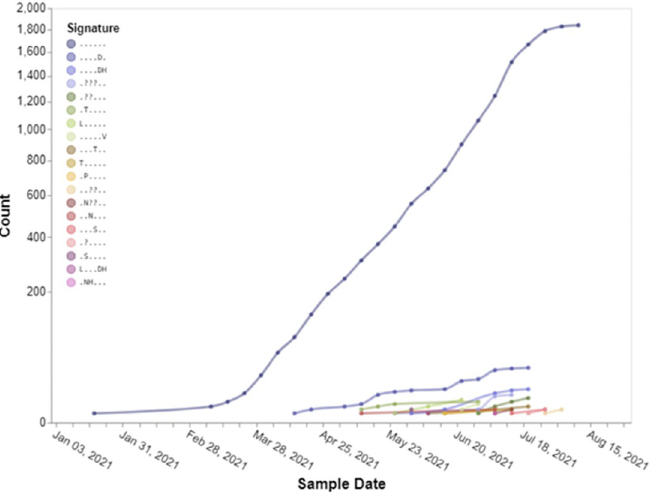
Fig 4. Temporal trends of the substitution combinations at selected sites represented in Table 4 in the Spike gene for B.1.621 ( μ ) sequences in 2021 (from left to right: S/27, S/146, S/147, S/1258, S/1259). The symbol “.” denotes the reference residue at that site. Figures like this can be generated using Trends in mutational patterns across SARS-CoV- 2 Spike enabled by data from https://observablehq.com/@spond/spike-trends. Additional search parameters include “B.1.621[pangolin] AND 20210101[after]”. Notebook link: https://observablehq.com/@spond/spike-trends.